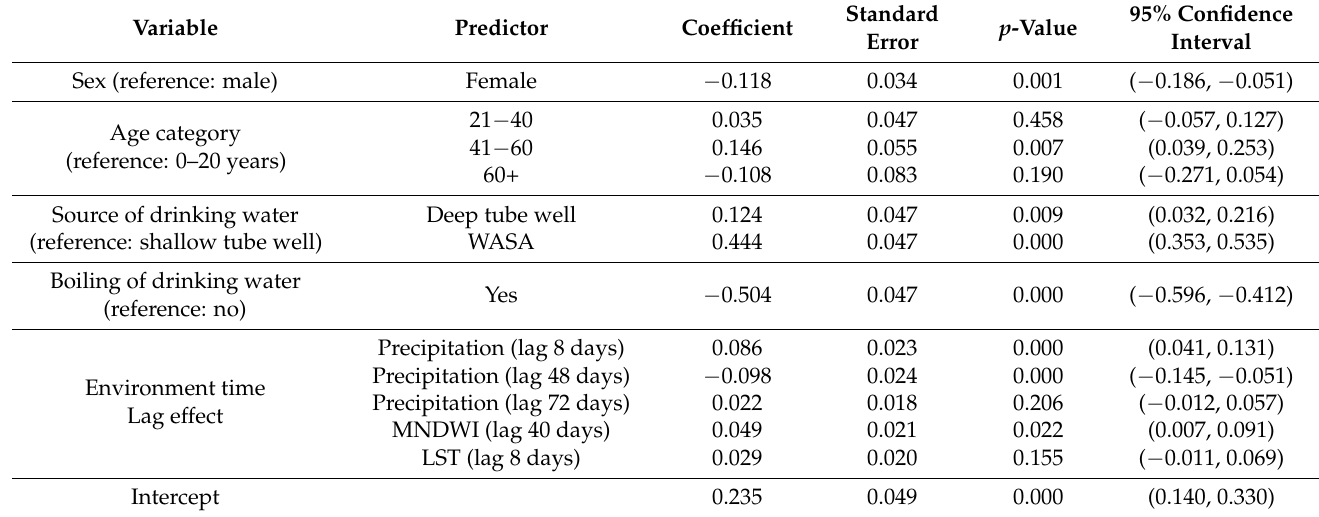
Table 3. Results of the final multivariable Bernoulli GLM of associations between HEV infection and demographic, contextual and environmental factors.